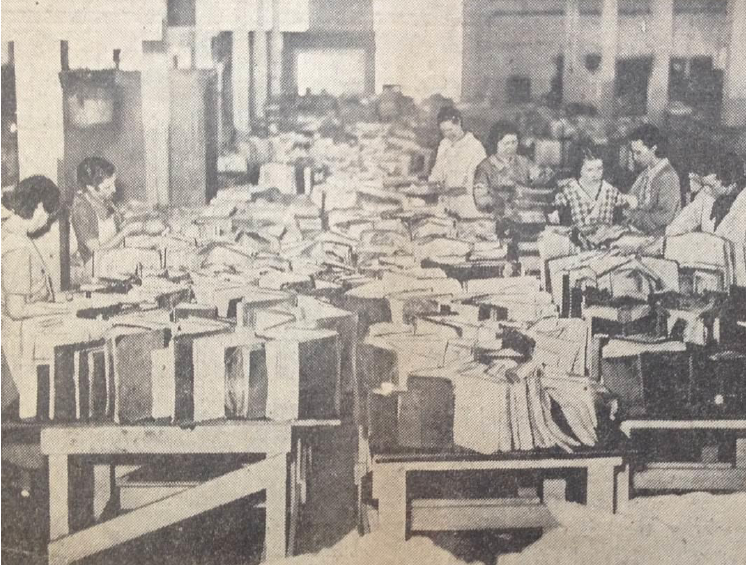
Figure 2 Books from the James V. Brown Library at the Electrical Services Supply Company, Philadelphia, before being placed in ESSC’s drying oven. Undated newspaper clipping from James V. Brown Library scrapbook, ca. April